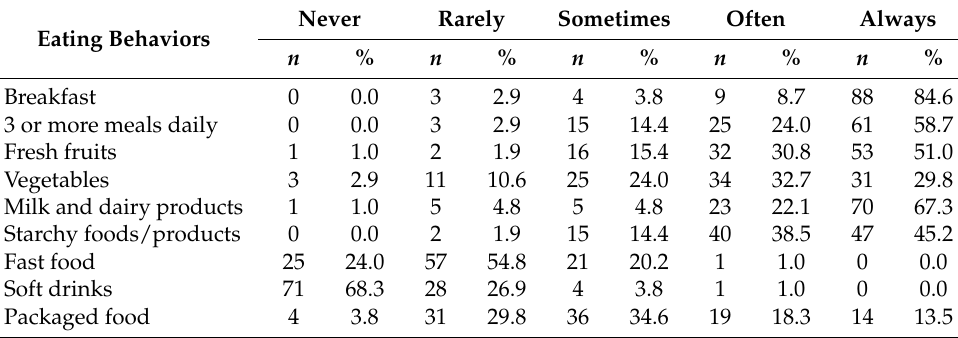
Table 1. Eating behavior patterns/frequency of children.